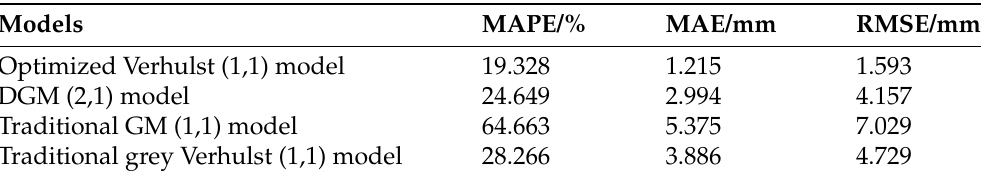
Table 2. The accuracy comparison between the fitted and actual value of four models for the